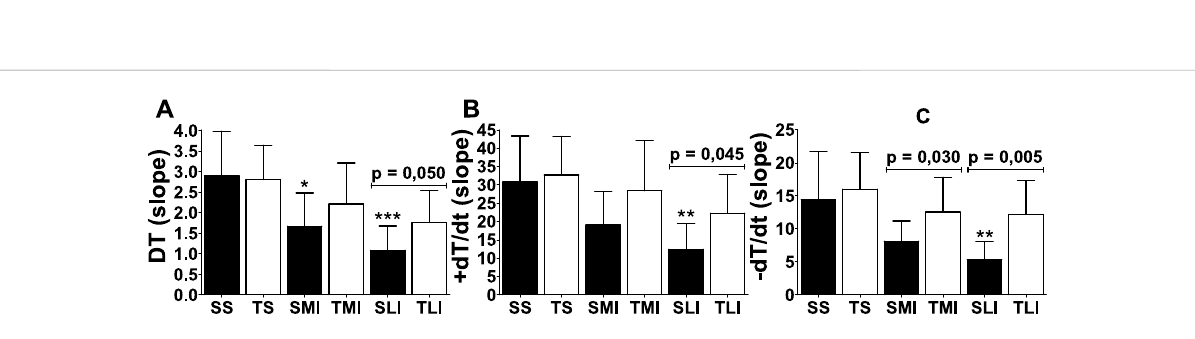
FIGURE 3 Responsiveness (slope) of inotropic (DT and +dT/dt) and lusitropic ( − dT/dt) functions of papillary muscles of sedentary rats (closed bars) and trained rats (open bars) with different myocardial infarction size (sedentary sham: SS, trained sham: TS, sedentary moderate infarction: SMI,